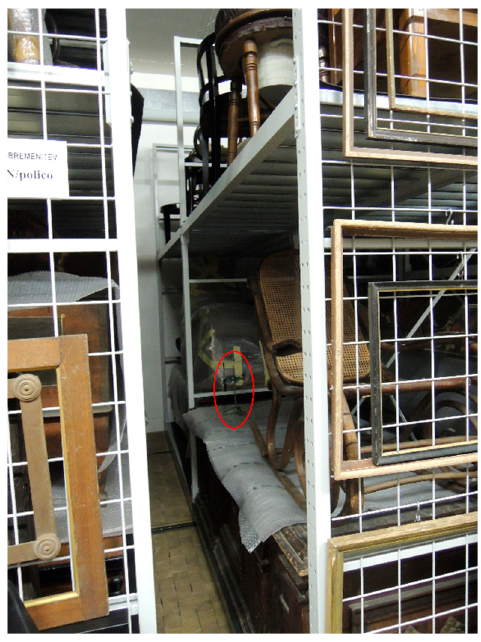
Figure 9. Museum depot air HS SPME sampling location No. 1, the SPME holder circled in red. Figure 9. In situ HS SPME sampling of OBJ4, the SPME holder circled in